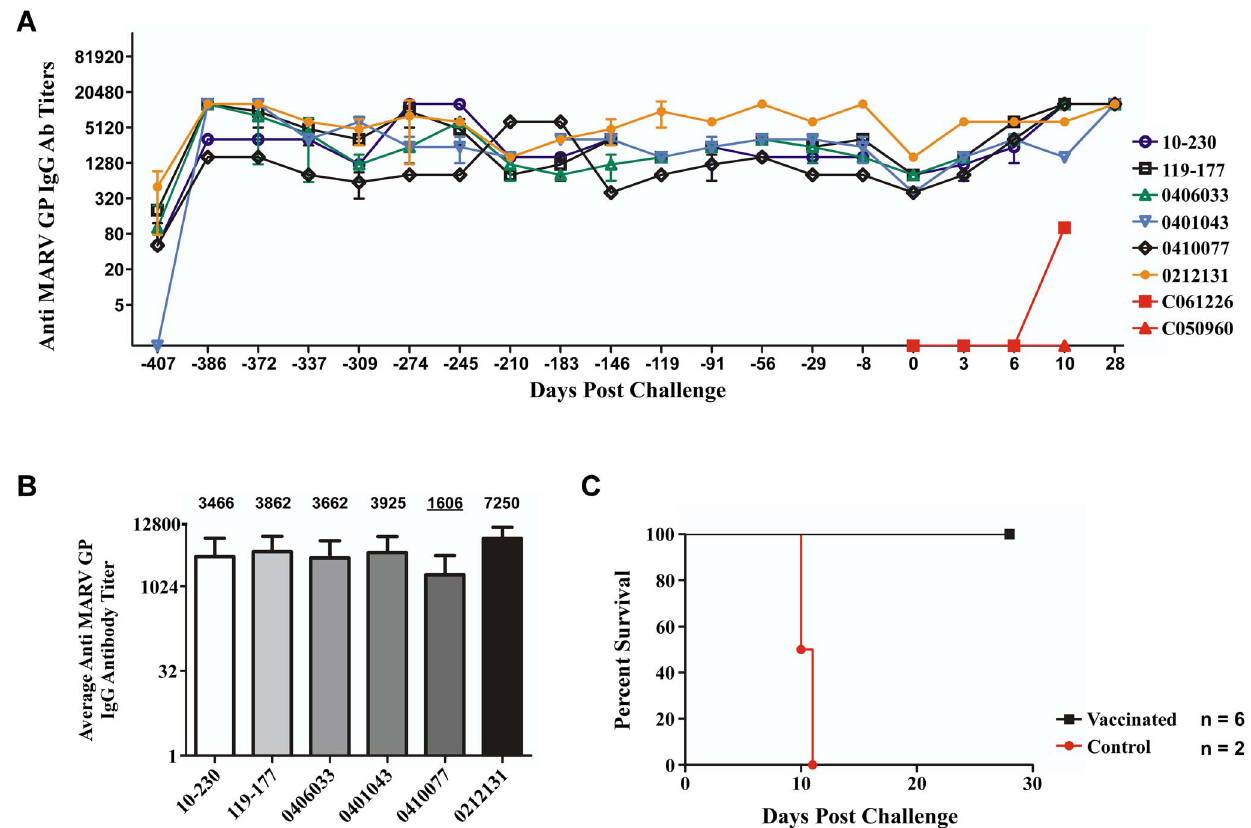
Figure 2. Circulating anti-MARV GP IgG and survival of vaccinated and control groups. (A) An ELISA was performed to measure the mean reciprocal titer of circulating anti-MARV GP IgG for each individual in the vaccinated cohort over the course of the 13 months before MARV challenge -407 to -8 and circulating anti-MARV GP IgG on the day of challenge (0) and days post-challenge for the non-vaccinated controls (red) and vaccinated cohort (top 6 in legend). Error bars represent standard deviation of samples in triplicate. (B) The average, over 13 months post-vaccination, mean reciprocal titer of circulating anti-MARV GP IgG before MARV challenge for each individual in the vaccinated cohort. Numerical value of average mean reciprocal titer displayed above individual bars in graph. Lowest average titer underlined. (C) Kapplan-Meier survival curve for the non-vaccinated control (red, n=2)) and vaccinated groups (black, n=6).